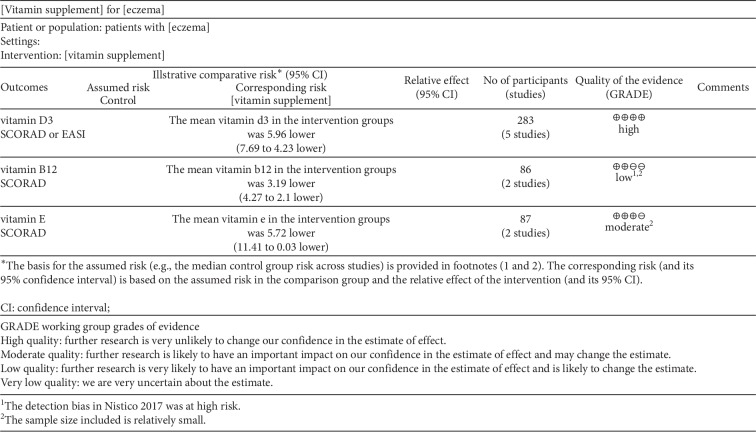
Summary of findings.